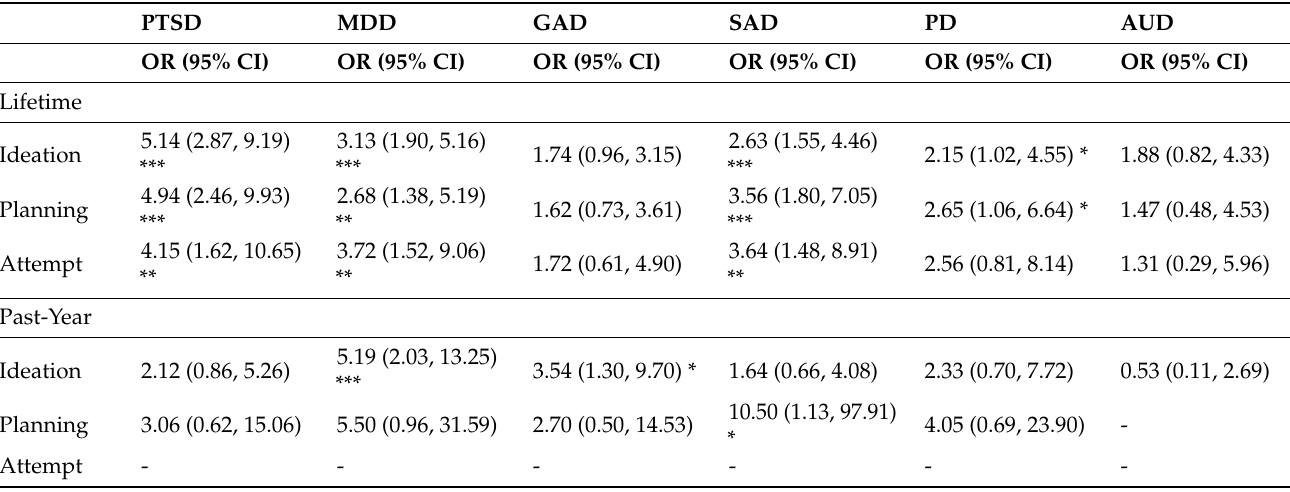
Table 4. Associations Between Past-Year and Lifetime Suicidal ideation, planning, and attempts and Mental